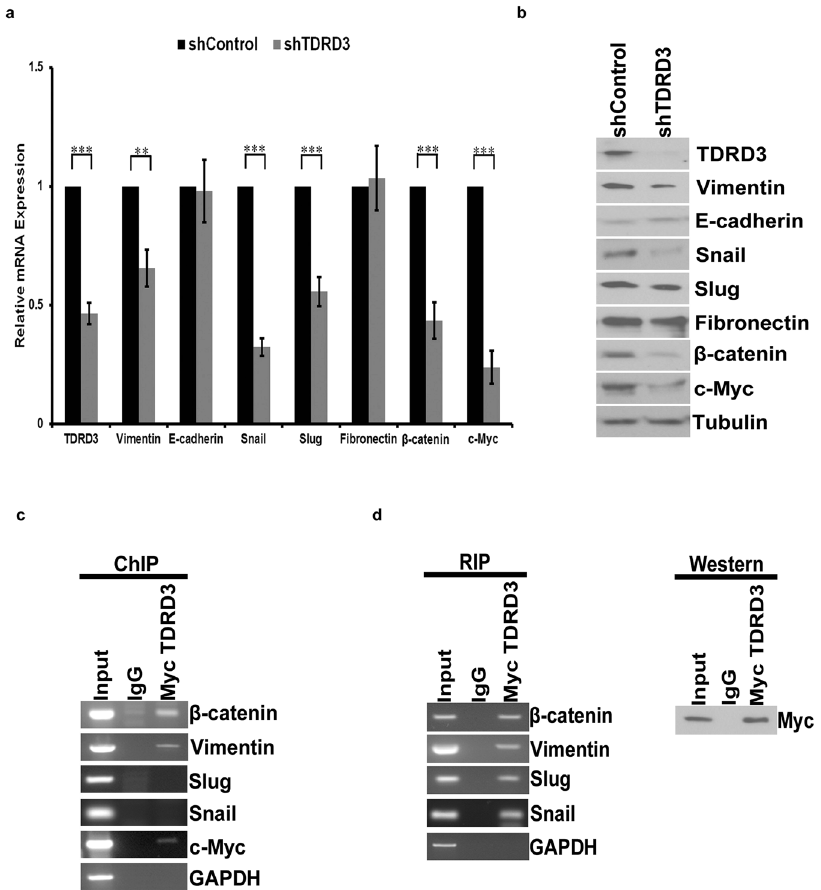
Figure 5. TDRD3 Regulates Epithelial to Mesenchymal Markers in Breast Cancer Cells. ( a ) MDA MB 231 cells were infected with shControl or shTDRD3 expressing lentivirus for 96 h, RNA was isolated, and qPCR was performed from cDNA synthesized from the RNA. Data was normalized to GAPDH and is the mean + / − SEM (n = 6). Significance ( ** p < 0.01, *** p < 0.001) was determined using a two-tailed t -test. ( b ) MDA MB 231